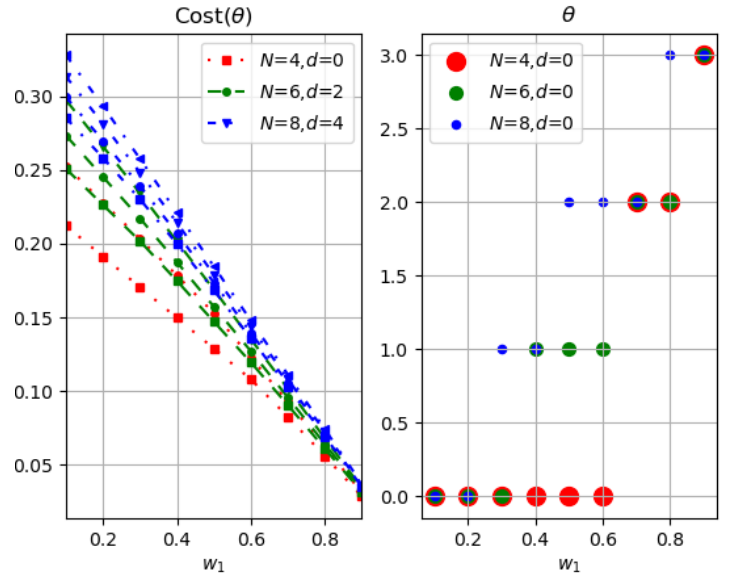
Figure 10. Min cost function versus weight factor, and corresponding θ for SNR = 8, [ N , d ] from left to right,